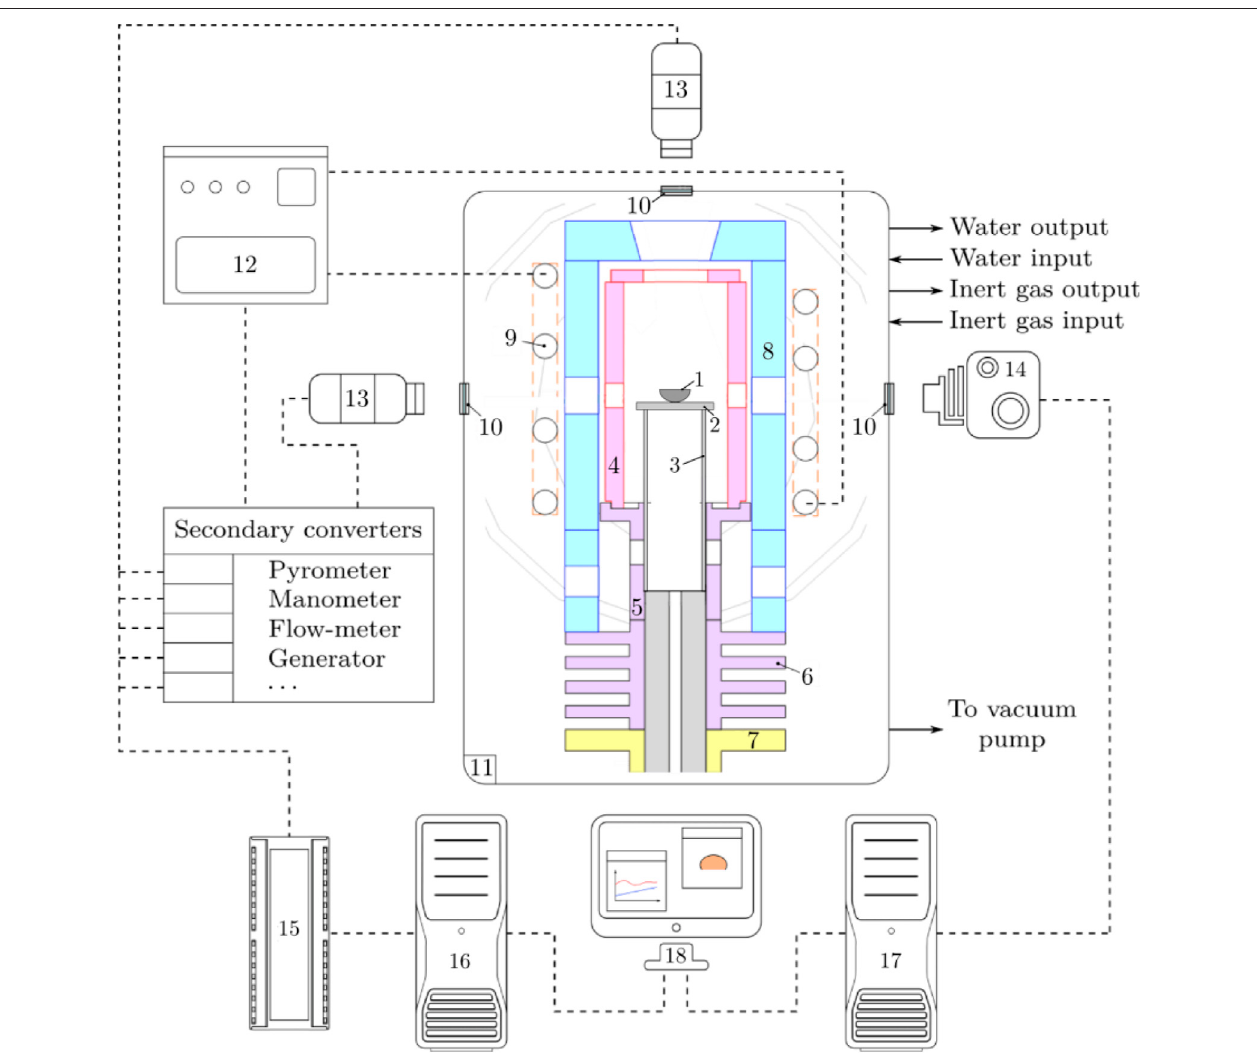
FIGURE 8 | Overall layout of VITI-VPA con fi guration (Delacroix, et al., 2019). 1: corium sample; 2: substrate; 3: substrate support; 4: susceptor; 5: susceptor support; 6: fi ns; 7: global support; 8: thermal shield; 9: inductor; 10: windows; 11: con fi nement vessel; 12: generator; 13: pyrometers; 14: camera; 15: data bus; 16: acquisition PC; 17: imaging PC; 18: monitoring.